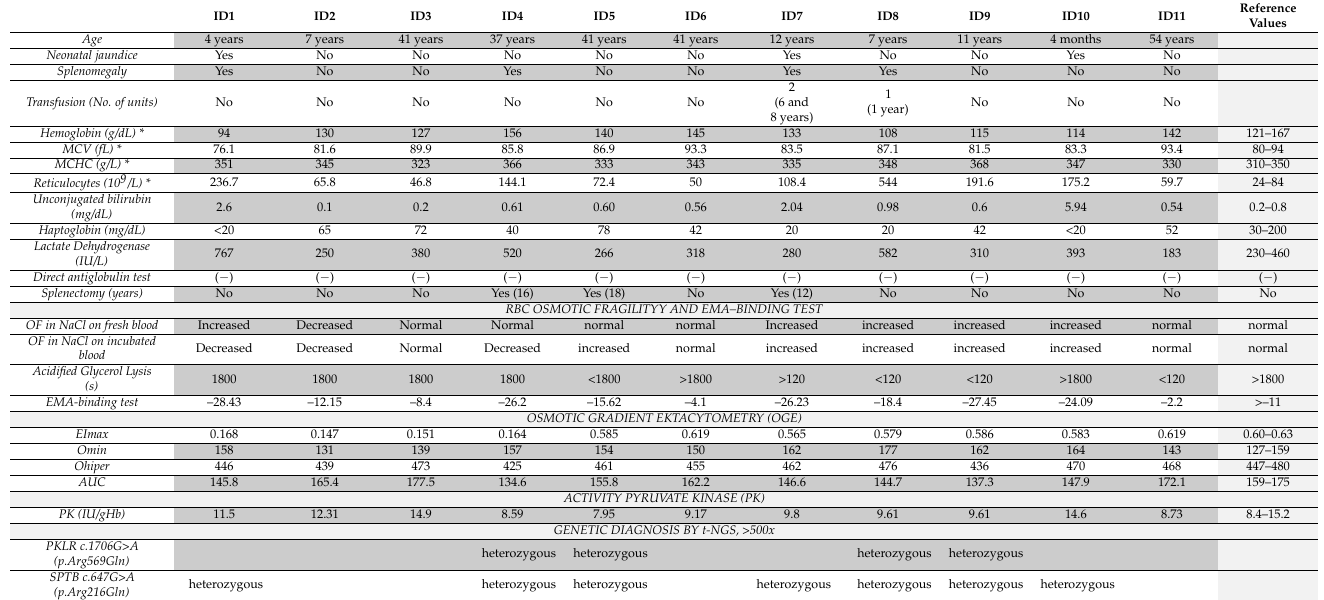
Table 1. Clinical, hematological, and genetic data of the family